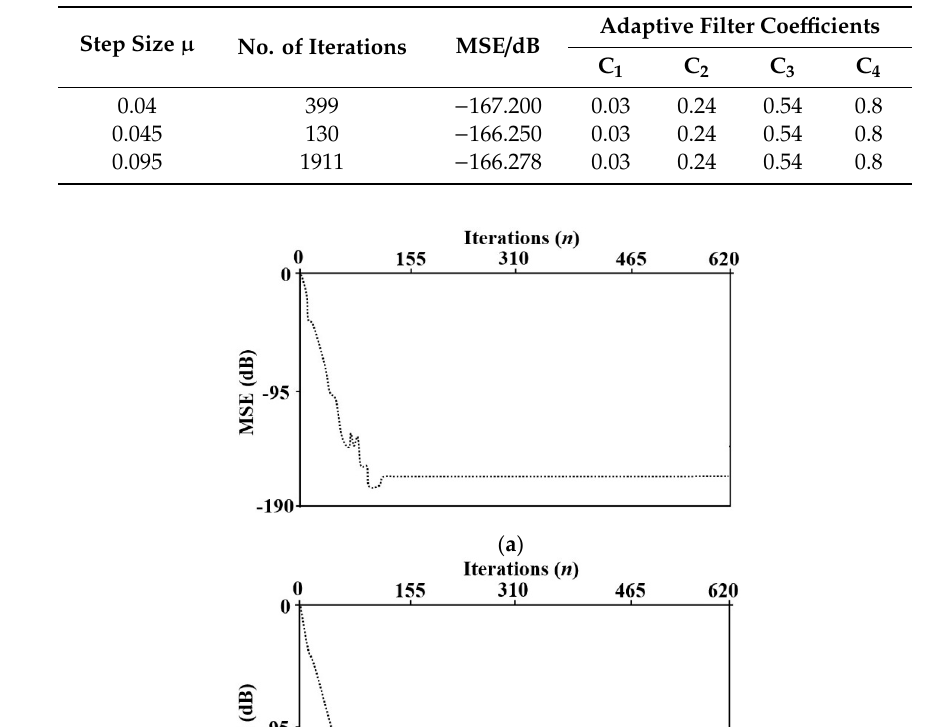
Table 1. Simulation results of FIR adaptation (white signal).